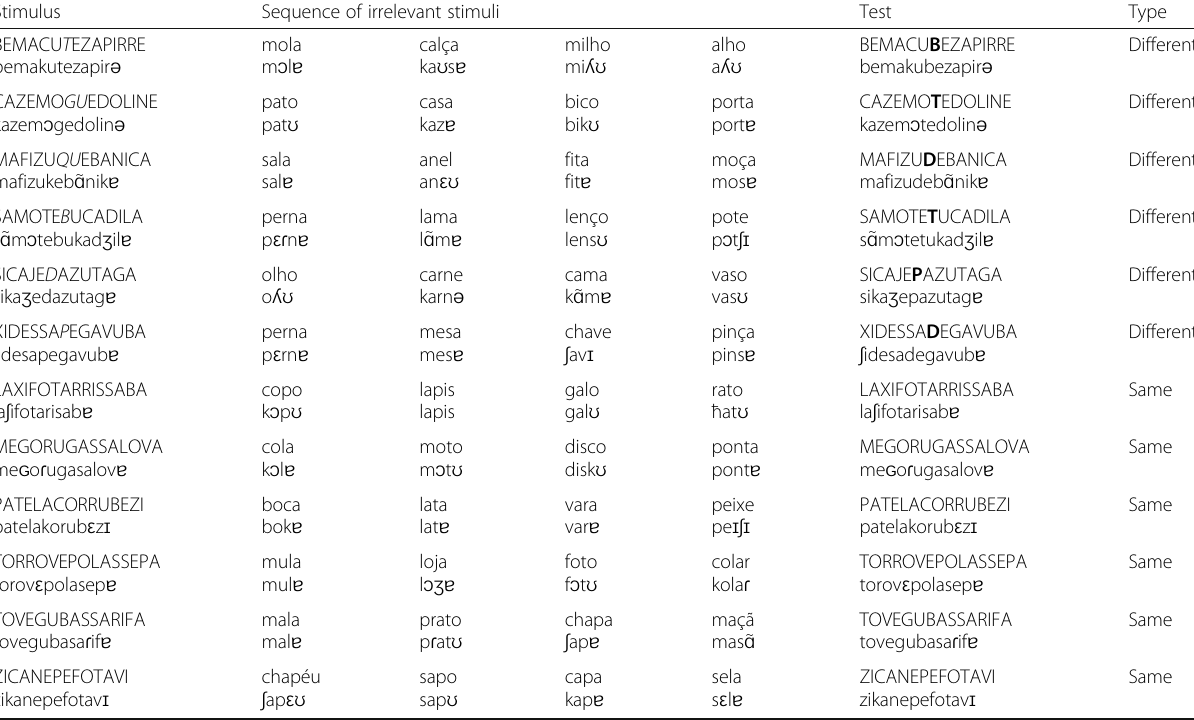
Table 5 The twelve pseudowords used as stimuli and the respective test stimuli, with the irrelevant words that were presented during the retention interval. Phonetic transcriptions are provided below the stimuli. The test stimulus could be the same as the memorized one, or the consonant of the central syllable was changed in the “ different ”